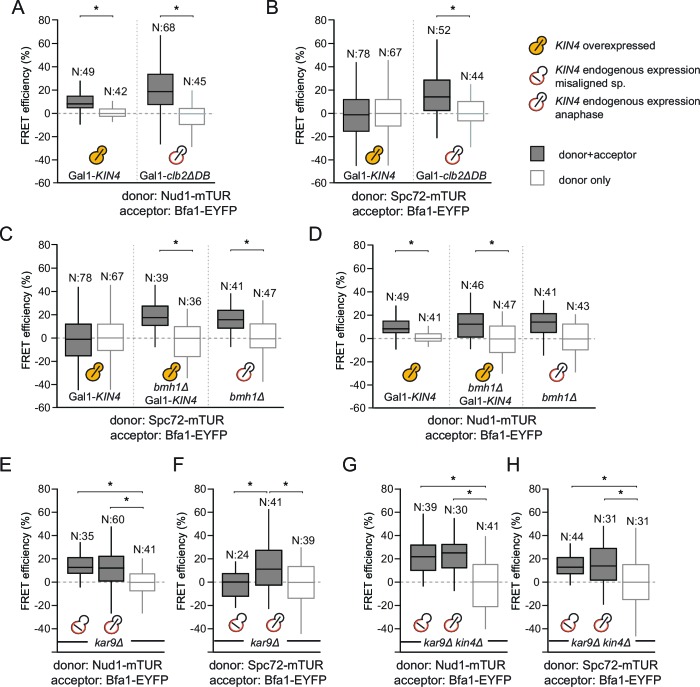
SPOC activation interferes with Bfa1-Spc72 interaction.(A–B) FRET efficiencies for Nud1-Bfa1 (A) and Spc72-Bfa1 (B) pairs. Cells were arrested in anaphase by clb2△DB overexpression (Gal1-clb2△DB) or by KIN4 overexpression (Gal1-KIN4). (C–D) FRET efficiencies for Spc72-Bfa1 (C) and Nud1-Bfa1 (D) pairs in Gal1-KIN4 (please note that the data for Gal1-KIN4 cells is identical to Figure 3A), Gal1-KIN4 bmh1∆ and bmh1∆ cells grown in galactose medium. (E–F) FRET efficiencies for Nud1-Bfa1 (E) and Spc72-Bfa1 (F) pairs in kar9Δ cells with correct and mis-aligned spindles. (G–H) FRET efficiencies of Nud1-Bfa1 (G) and Spc72-Bfa1 (H) pairs in kar9Δ kin4∆ cells with correct and mis-aligned spindles. Box-whisker plots in G and H are one out of two technical replicates from the same experiment. N: sample size. Asterisks show significant difference according to student’s t-test (p<0.01). See the accompanying data files for exact p-values (Figure 3—source data 1–8).DOI:
http://dx.doi.org/10.7554/eLife.14029.01810.7554/eLife.14029.019Figure 3—source data 1.Raw data and the calculated FRET efficiencies of Nud1-Bfa1 and Spc72-Bfa1 pairs at SPBs upon KIN4 overexpression (source data for Figure 3A).DOI:
http://dx.doi.org/10.7554/eLife.14029.01910.7554/eLife.14029.020Figure 3—source data 2.Raw data and the calculated FRET efficiencies of the Spc72-Bfa1 pair at SPBs upon KIN4 overexpression, and CDC20 depletion (source data for Figure 3B).DOI:
http://dx.doi.org/10.7554/eLife.14029.02010.7554/eLife.14029.021Figure 3—source data 3.Raw data and the calculated FRET efficiencies of the Spc72-Bfa1 pair in the presence and absence of BMH1 (source data for Figure 3C).DOI:
http://dx.doi.org/10.7554/eLife.14029.02110.7554/eLife.14029.022Figure 3—source data 4.Raw data and the calculated FRET efficiencies of the Nud1-Bfa1 pair in the presence and absence of BMH1 (source data for Figure 3D).DOI:
http://dx.doi.org/10.7554/eLife.14029.02210.7554/eLife.14029.023Figure 3—source data 5.Raw data and the calculated FRET efficiencies of the Nud1-Bfa1 pair in kar9∆ cells with normally aligned or misaligned spindles (source data for Figure 3E).DOI:
http://dx.doi.org/10.7554/eLife.14029.02310.7554/eLife.14029.024Figure 3—source data 6.Raw data and the calculated FRET efficiencies of the Spc72-Bfa1 pair in kar9∆ cells with normally aligned or misaligned spindles (source data for Figure 3F).DOI:
http://dx.doi.org/10.7554/eLife.14029.02410.7554/eLife.14029.025Figure 3—source data 7.Raw data and the calculated FRET efficiencies of the Nud1-Bfa1 pair in kar9∆ kin4∆ cells with normally aligned or misaligned spindles (source data for Figure 3G).DOI:
http://dx.doi.org/10.7554/eLife.14029.02510.7554/eLife.14029.026Figure 3—source data 8.Raw data and the calculated FRET efficiencies of the Spc72-Bfa1 pair in kar9∆ kin4∆ cells with normally aligned or misaligned spindles (source data for Figure 3H).